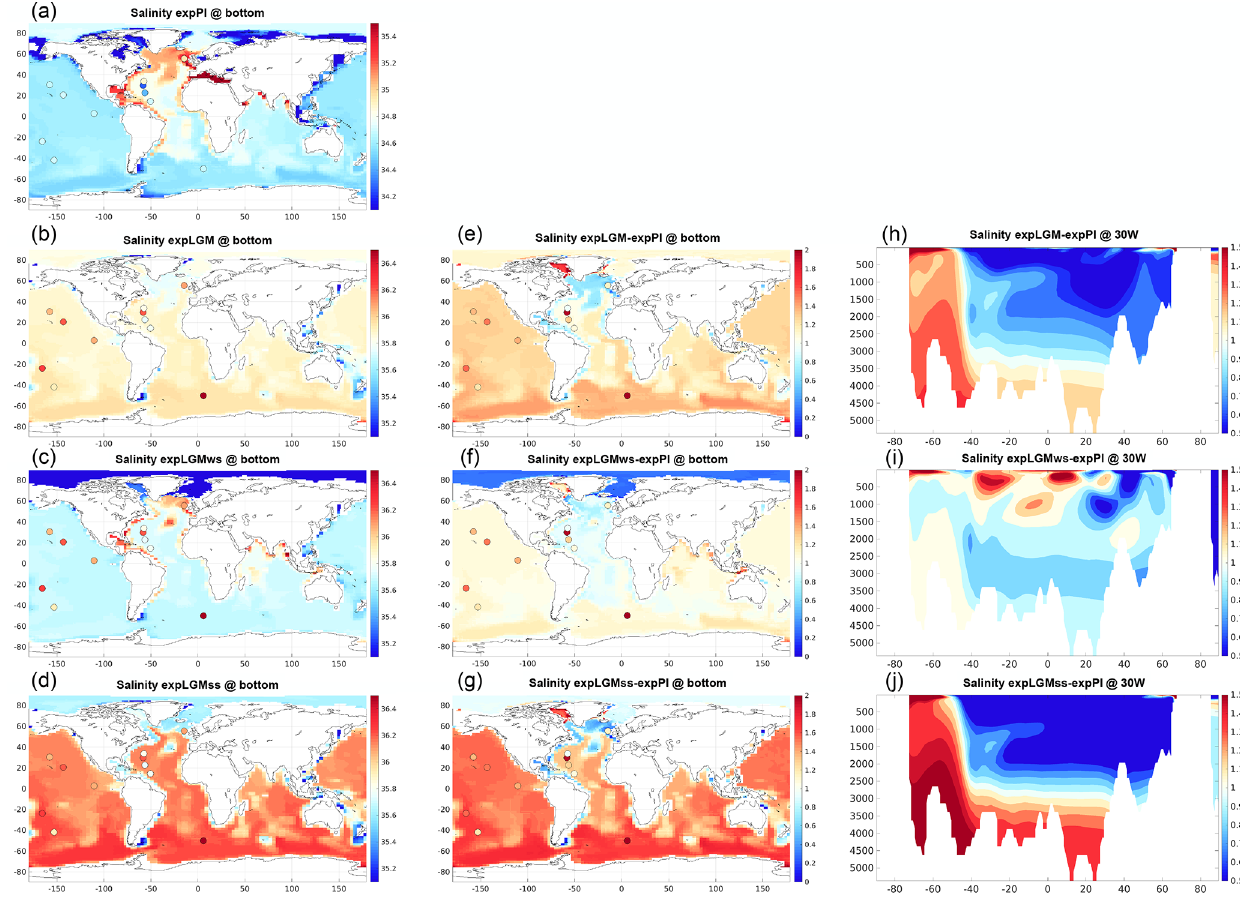
Figure 4. Simulated salinity for the main experiments in this study. The left and middle columns show the global distributions of salinity in the bottom-most grid cells. The absolute values for (a) expPI, (b) expLGM, (c) expLGMws, and (d) expLGMss and the differences between each LGM experiment and expPI are shown (e–g) . The coloured dots indicate the reconstructions by Adkins et al. (2002), Insua et al. (2014), and Homola et al. (2021). The meridional sections in the Atlantic (30 ◦ W) are also shown for the anomalies (h–j) . The average states of the last 50 years are